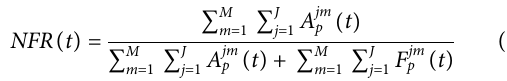
Frontiers in Earth Science |